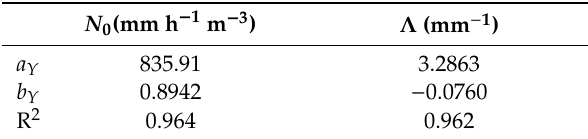
Table 4. Best-fit parameters a Y and b Y (Equation (11)) for both N 0 and Λ , expressed as a function of RI , and the associated correlation factors.